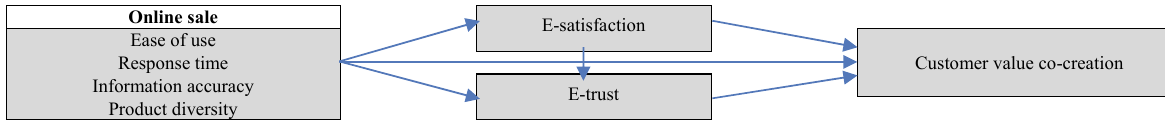
Fig. 1. Research theoretical